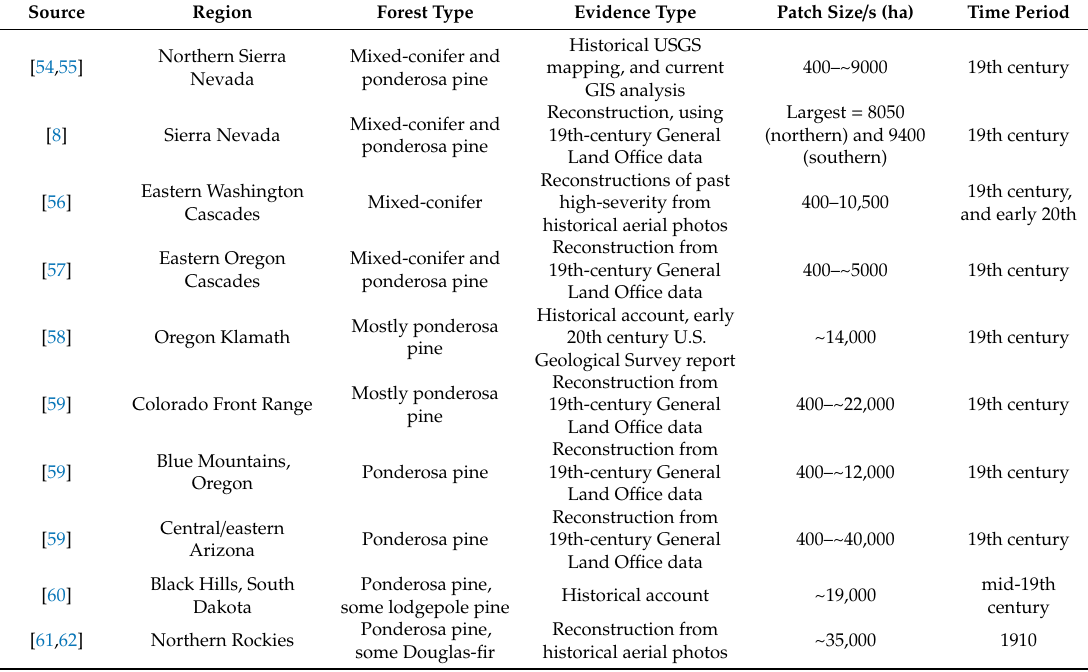
Table 5. Examples of historical occurrence of CESF patches > 400 ha, created by high-severity fire, in low / middle-montane forests of the western USA 1